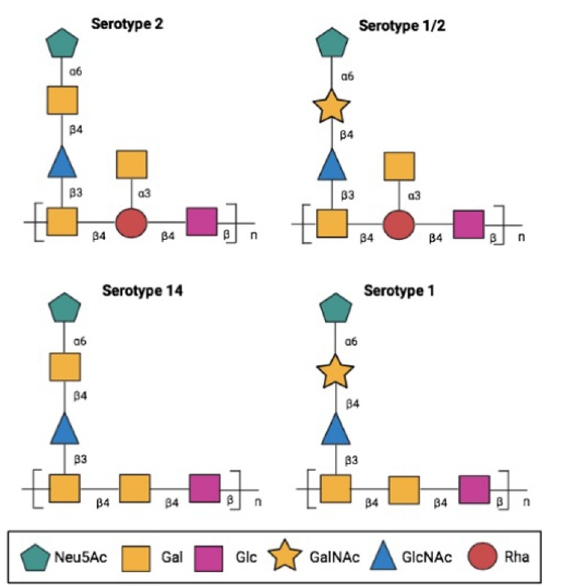
Fig 3. The difference structure of the CPS repeating units among S . suis serotypes 2, 1/2, 1, and 14 as modified from Goyette-Desjardins et al. [20]. Abbreviations: N -acetyl-d-neuraminic acid (Neu5Ac), D-galactose (Gal), D- glucose (Glc), N -acetyl-d-galactosamine (GalNAc), N -acetyl-d-glucosamine (GlcNAc), and L-rhamnose (Rha).